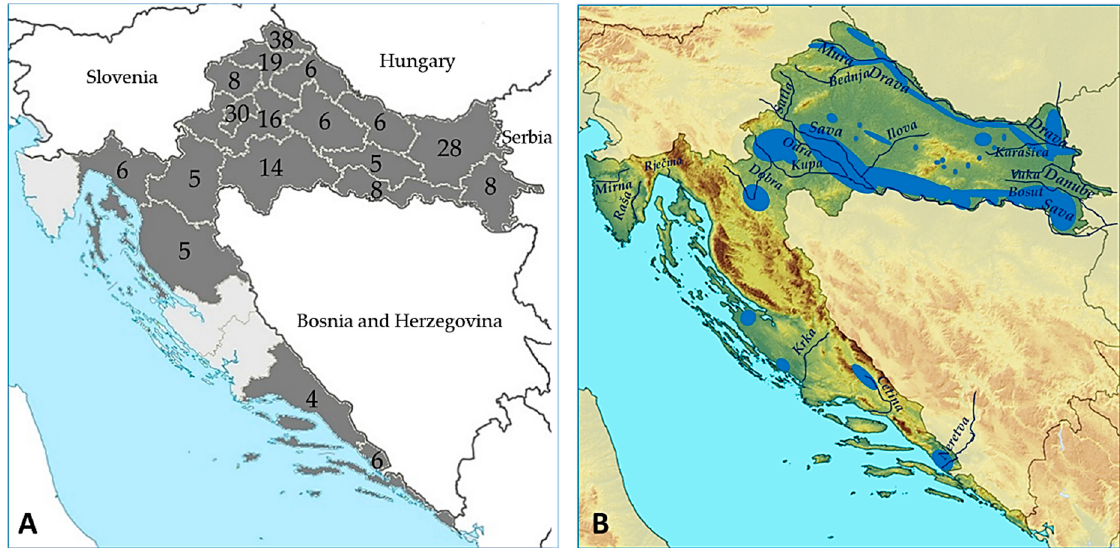
Figure 1. Sampling counties (shadowed gray) and number of patients sampled by county ( A ); Geomorphology of Croatia ( B ). Croatian lowland rivers flow through the plain of the former Pannonian Sea, forming large drainage basins. The longest rivers in continental Croatia are the Sava (562 km), Drava (505 km), Kupa (296 km), and a 188-kilometre section of the Danube. All of them more or less inundate flood meadows and flood forests. Croatia has a remarkable wealth of wetlands (large wetland areas are marked blue). The longest rivers emptying into the Adriatic Sea are the Cetina (101 km) and a 20 km section of the Neretva [28].